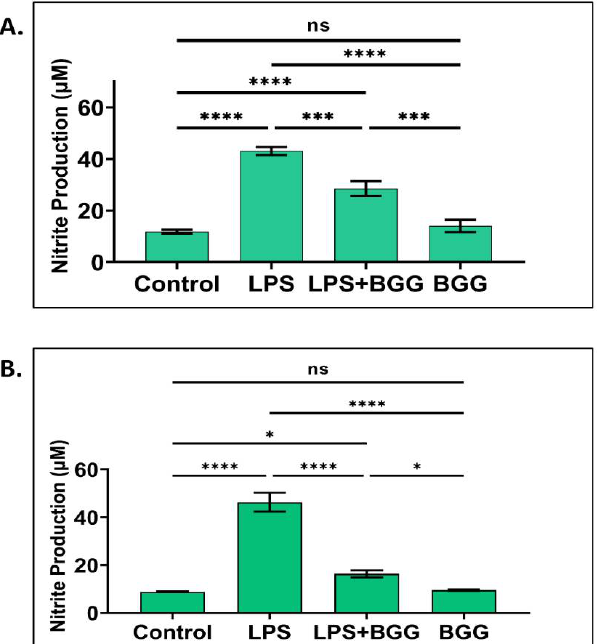
Figure 2. BGG attenuates the LPS-induced NO production in ( A ) RAW 264.7 and ( B ) mice peritoneal macrophages. Results are mentioned as mean ± SD ( n = 5), p -value ≤ 0.05. (* p ≤ 0.05, *** p < 0.001, and **** p < 0.0001) (ns: not